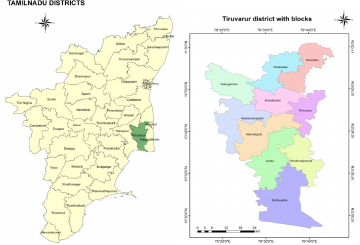
Fig.1 Location Map of Tiruvarur district in Tamil Nadu Satellite